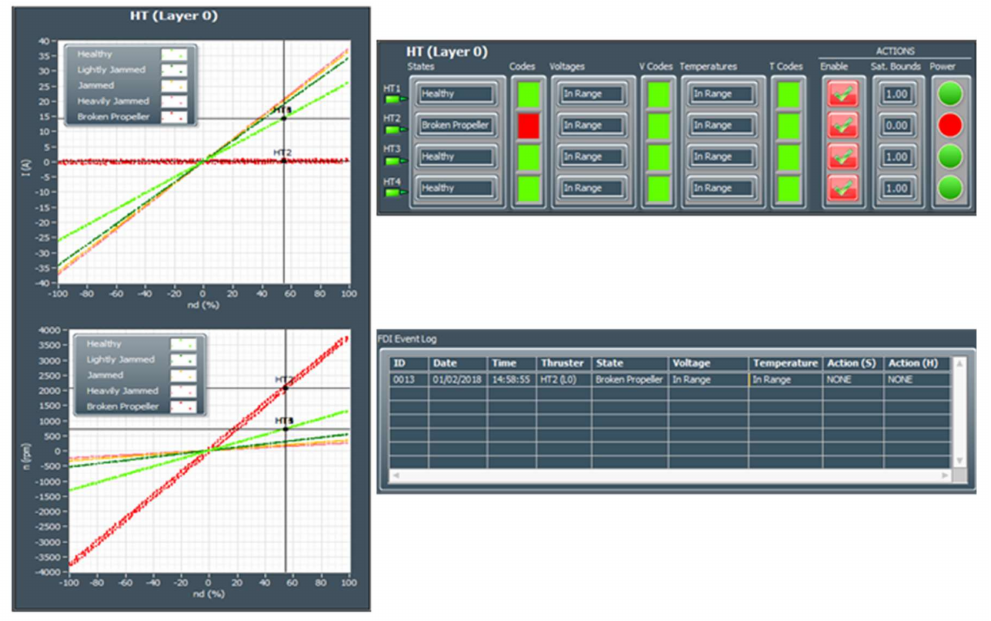
Figure 22. Test 1 (Open-Loop): Total fault in HT2 (“Broken Propeller”) with disabled fault